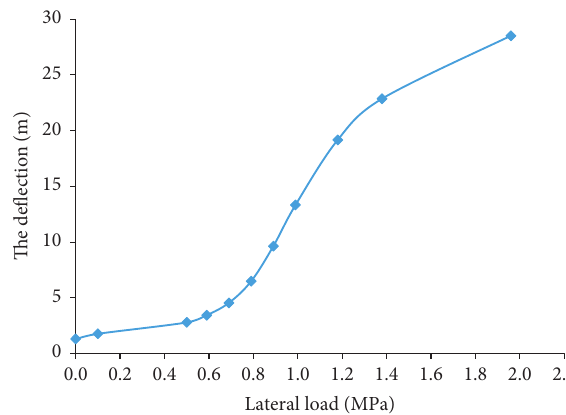
Figure 4: Deflection of the compressive column in